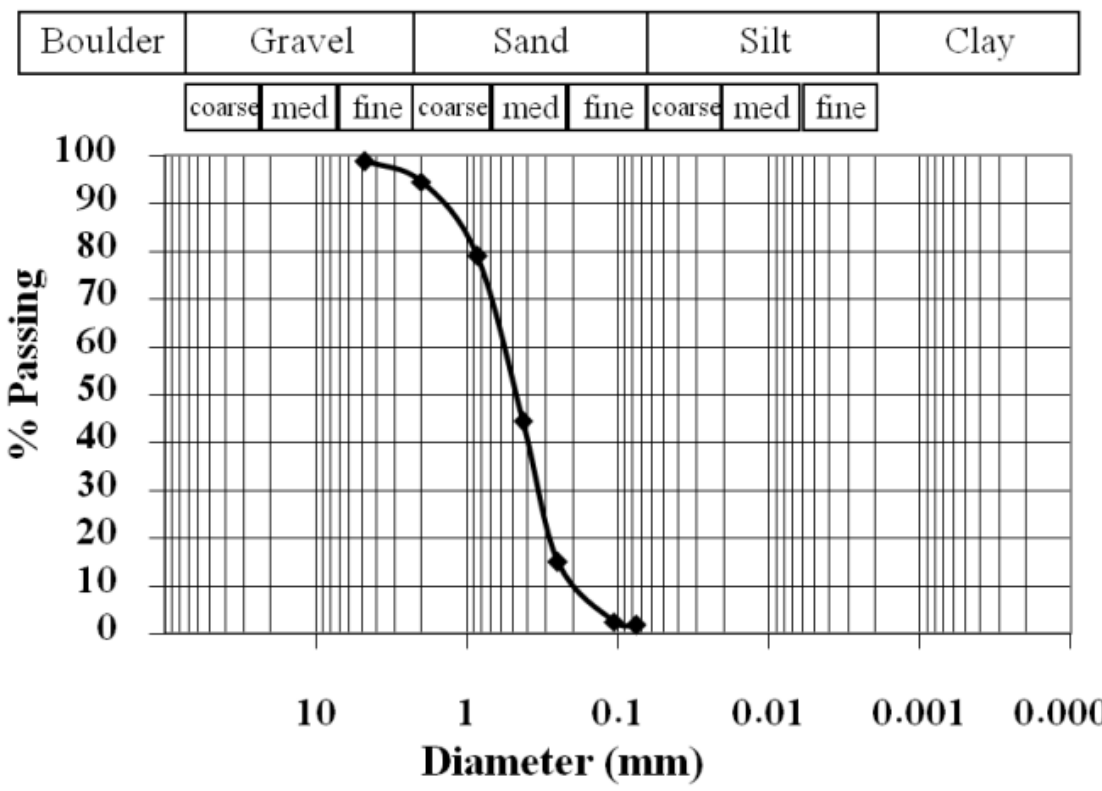
Figure 10. The sieve analysis of specimen 4 at 67.3E km at El-ferdan